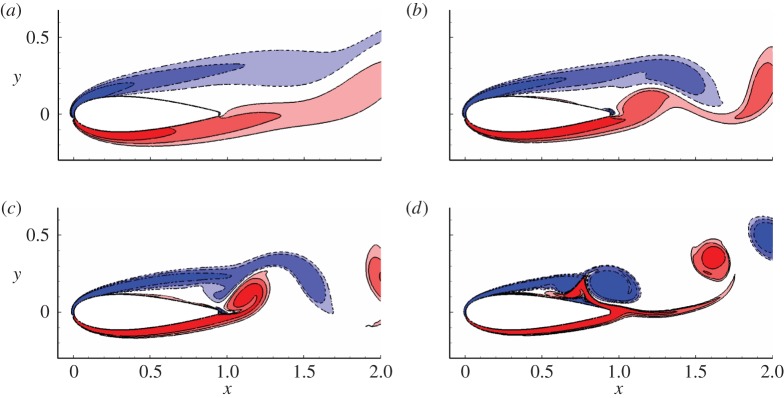
Contours of spanwise vorticity for the uncontrolled flow at α=10° and (a) Re=500, (b) Re=1000, (c) Re=2000 and (d) Re=5000, respectively. Contour levels are [−12,−6,−3,3,6,12], as will be used in all the following contour plots if not otherwise stated. (Online version in colour.)